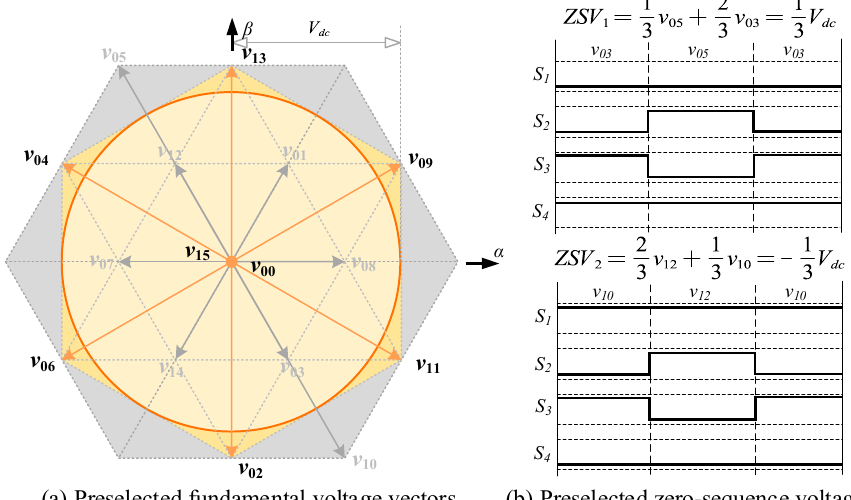
Figure 4. Preselected voltage vectors.